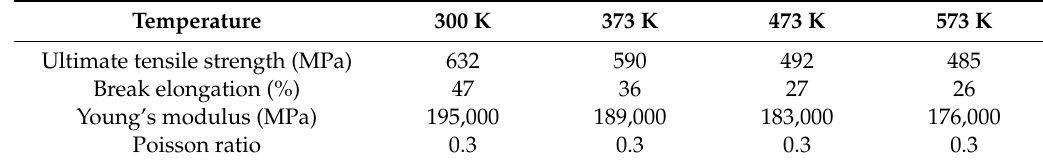
Table 2. The physical properties of the 316L austenitic stainless steel